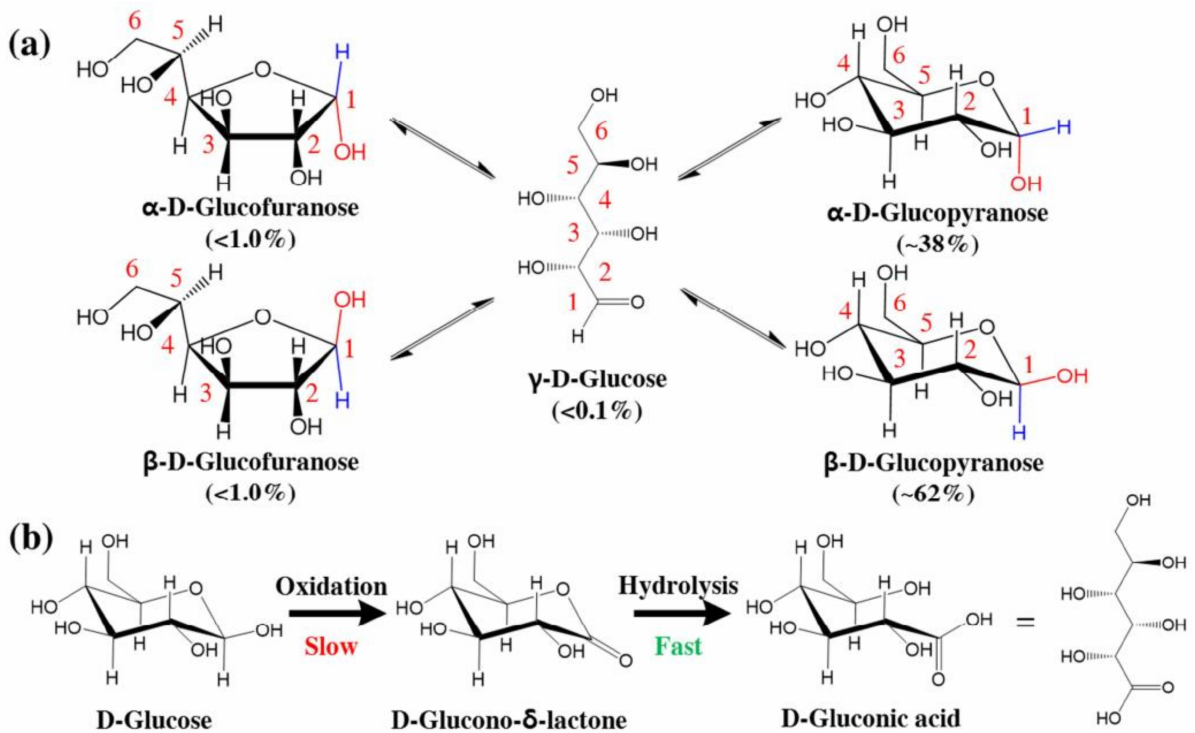
Figure 20. ( a ) Molecular patterns of different D-glucose isomers. ( b ) The whole process of oxidising glucose. Slow hydrogen abstraction and oxidation transform D-glucose into D-glucono- δ -lactone, which is then rapidly hydrolysed into D-gluconic acid. (Reproduced from [452] with permission. Copyright 2018, Elsevier, Amsterdam, The